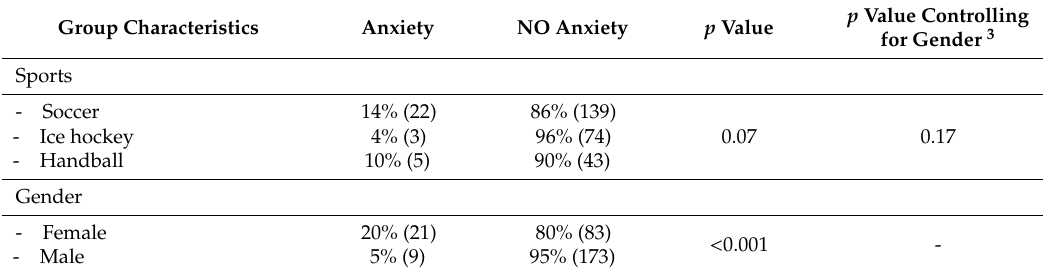
Table 4. Fulfillment of at least moderate anxiety symptoms (GAD-7 score of 10 or above), depending on other variables. Chi-squared analyses for group comparisons and logistic regression analyses for the analysis of each potential correlate when controlling for